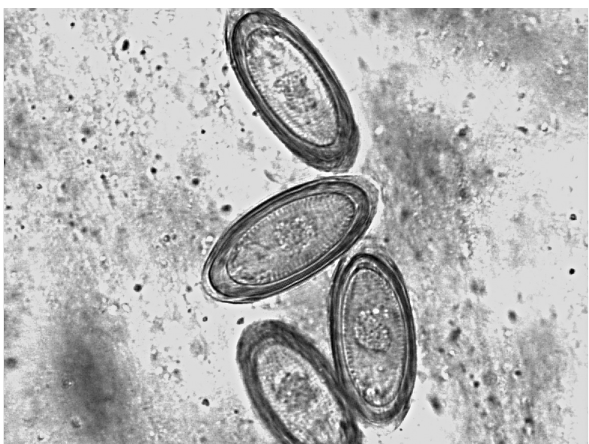
Fig. 1. – Eggs of acanthocephalans ( × 40) from a saker falcon (n = 1) with heavy